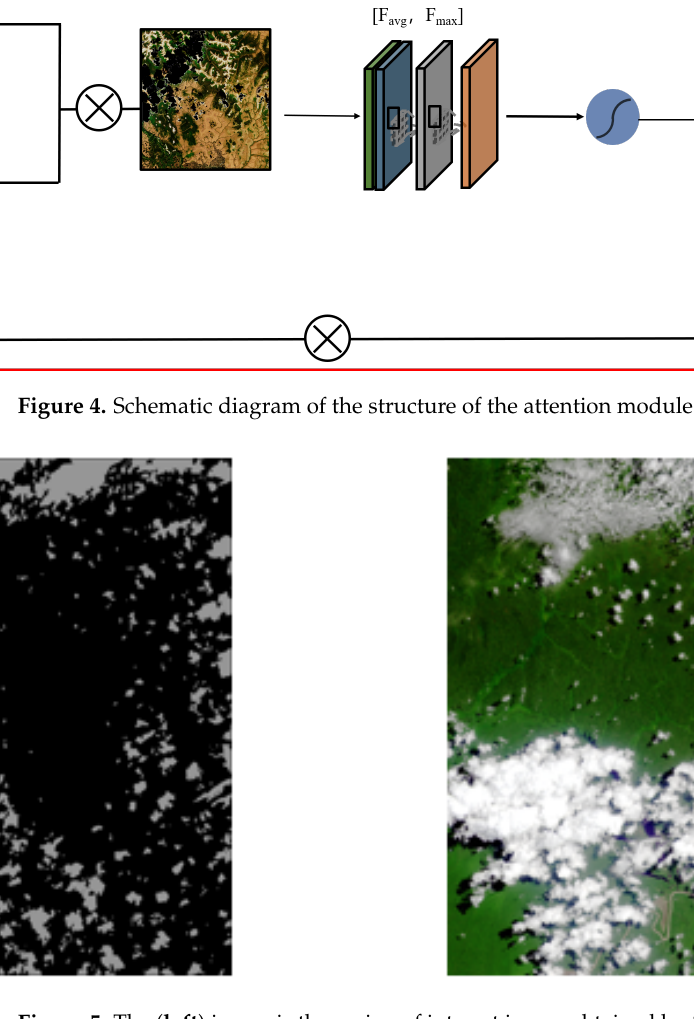
Figure 5. The ( left ) image is the region of interest image obtained by the cloud detection network [5], and the ( right ) image is the original color